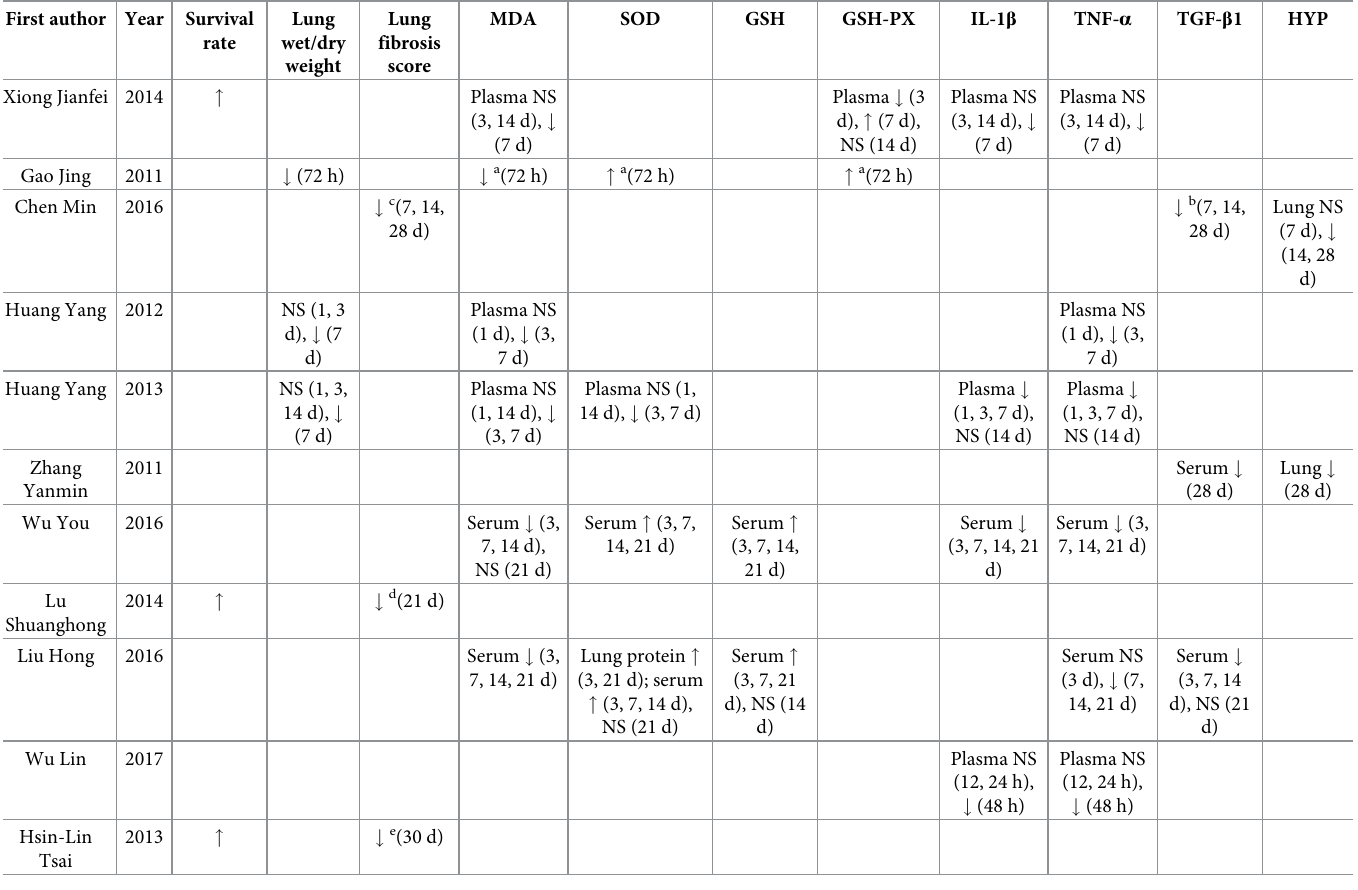
Table 2. Summary of the major experimental